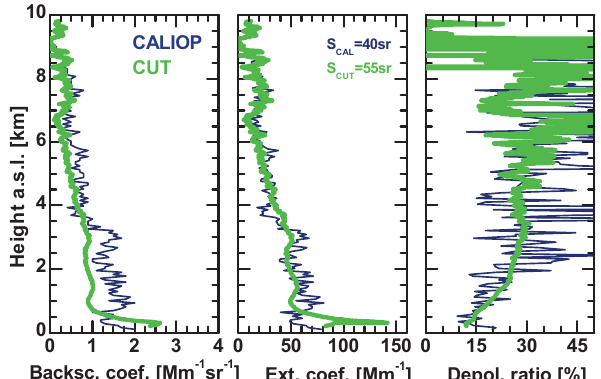
Figure 8. Comparison of profiles of particle backscatter coefficient, extinction coefficient, and particle linear depolarization ratio mea- sured with ground-based CUT lidar at Limassol (thick green curves, 60min means) on 1 June 22:28–23:28UTC, and with spaceborne CALIOP (blue noisy curves, 45km east of Limassol, during sec- onds 38–43 of 23:53UTC). In the case of CALIOP, 135 signal pro- files are averaged (nine level-2 aerosol profiles, 45km horizontal resolution). No vertical smoothing is applied to the CALIOP data. CUT lidar signal profiles were vertically smoothed by 180m. A li- dar ratio of S CAL = 40sr was selected in the retrieval of CALIOP data and S CUT = 55sr (optimum lidar ratio for this Saharan dust case after Mamouri et al. (2013)) was applied in the CUT computa- tion of backscatter and extinction